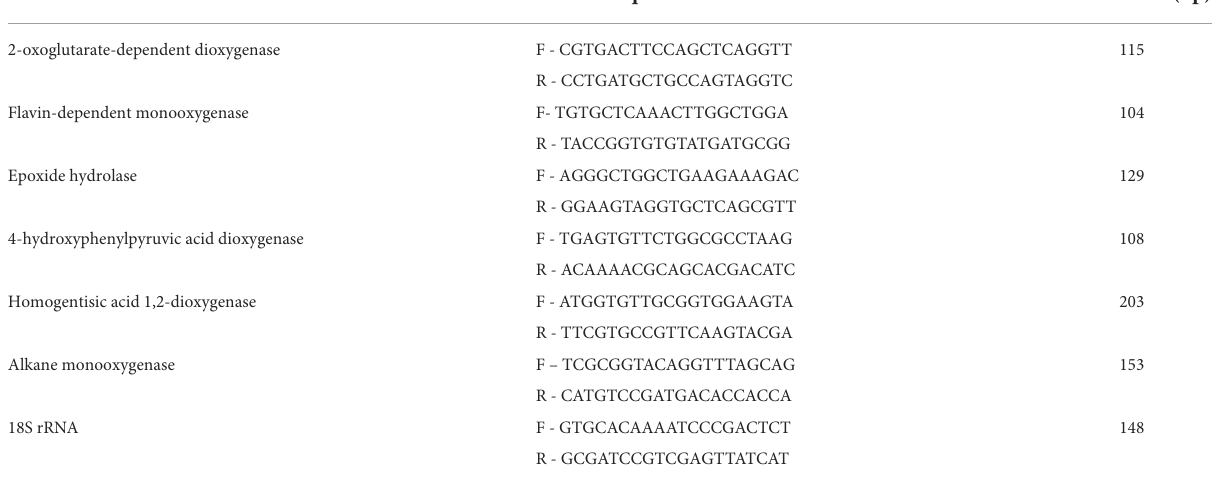
TABLE 1 Primers used for qRT-PCR of ANT degradation enzymes genes. Gene Primer